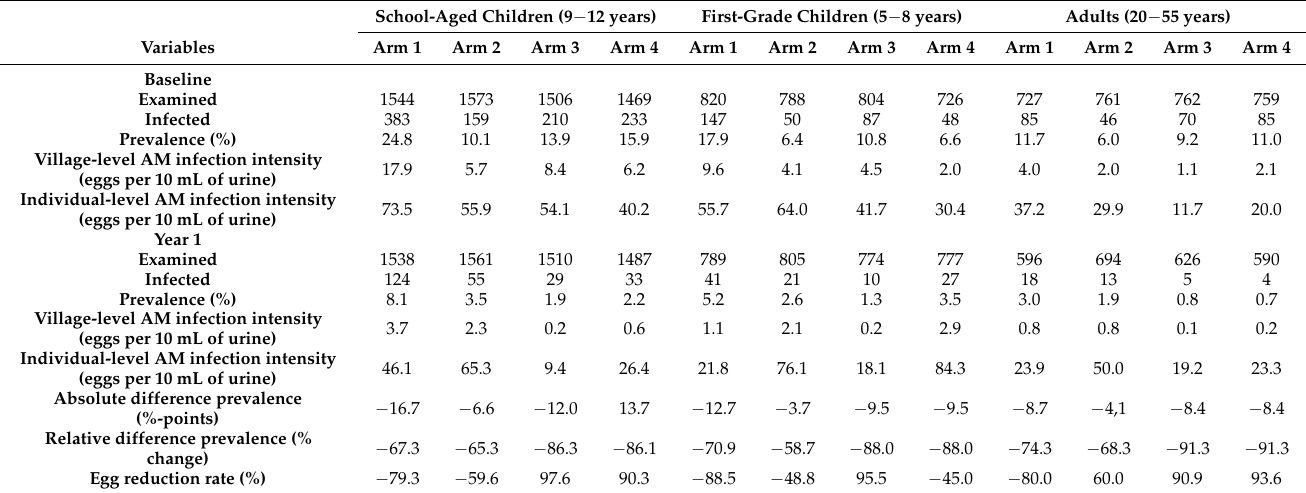
Table 2. Reduction of prevalence and intensity of S. haematobium from baseline to the first year treatment follow-up.